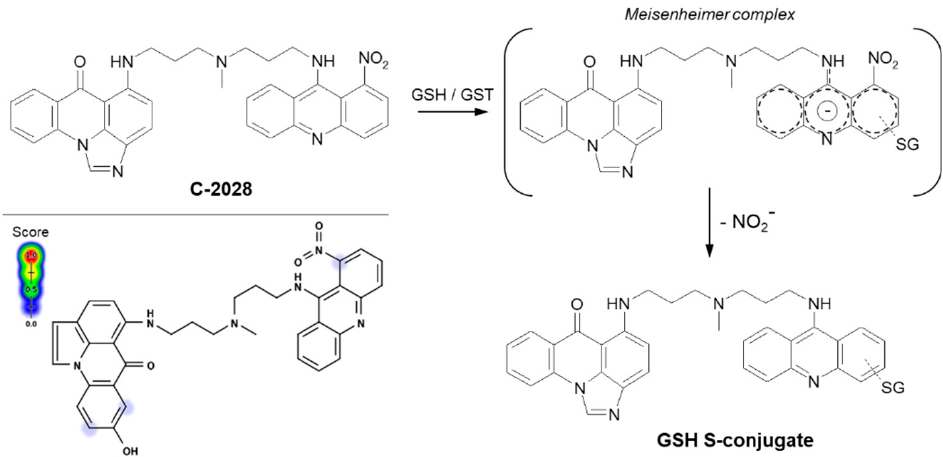
Figure 11. The proposed GSH-mediated metabolic pathway of C-2028, the representing anticancer unsymmetrical bisacridine derivative [25]. Predicted bioactive sites of GSH conjugation for anticancer agent were obtained by XenoSite Reactivity Predictor available at https://swami.wustl.edu/xenosite/p/reactivity (accessed on 18 May 2022).